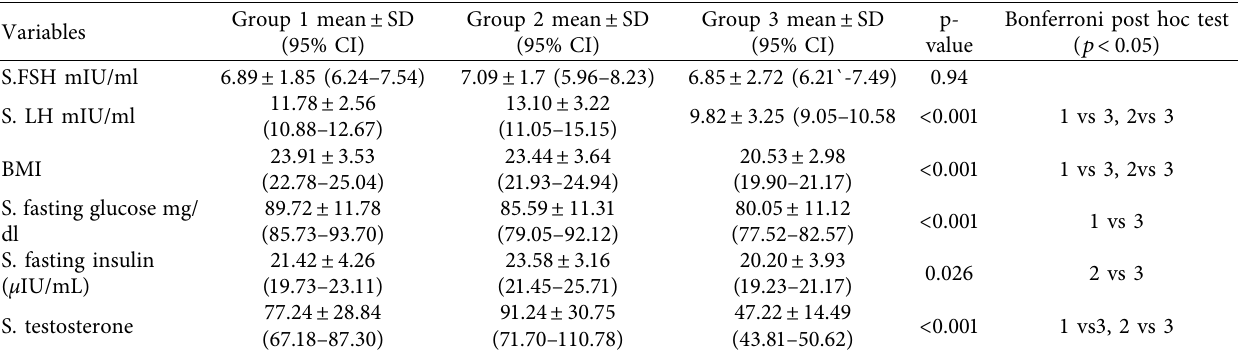
Table 4: Comparative analysis of endocrinal metabolic and hormonal parameters in different phenotypes of adolescent PCOS.